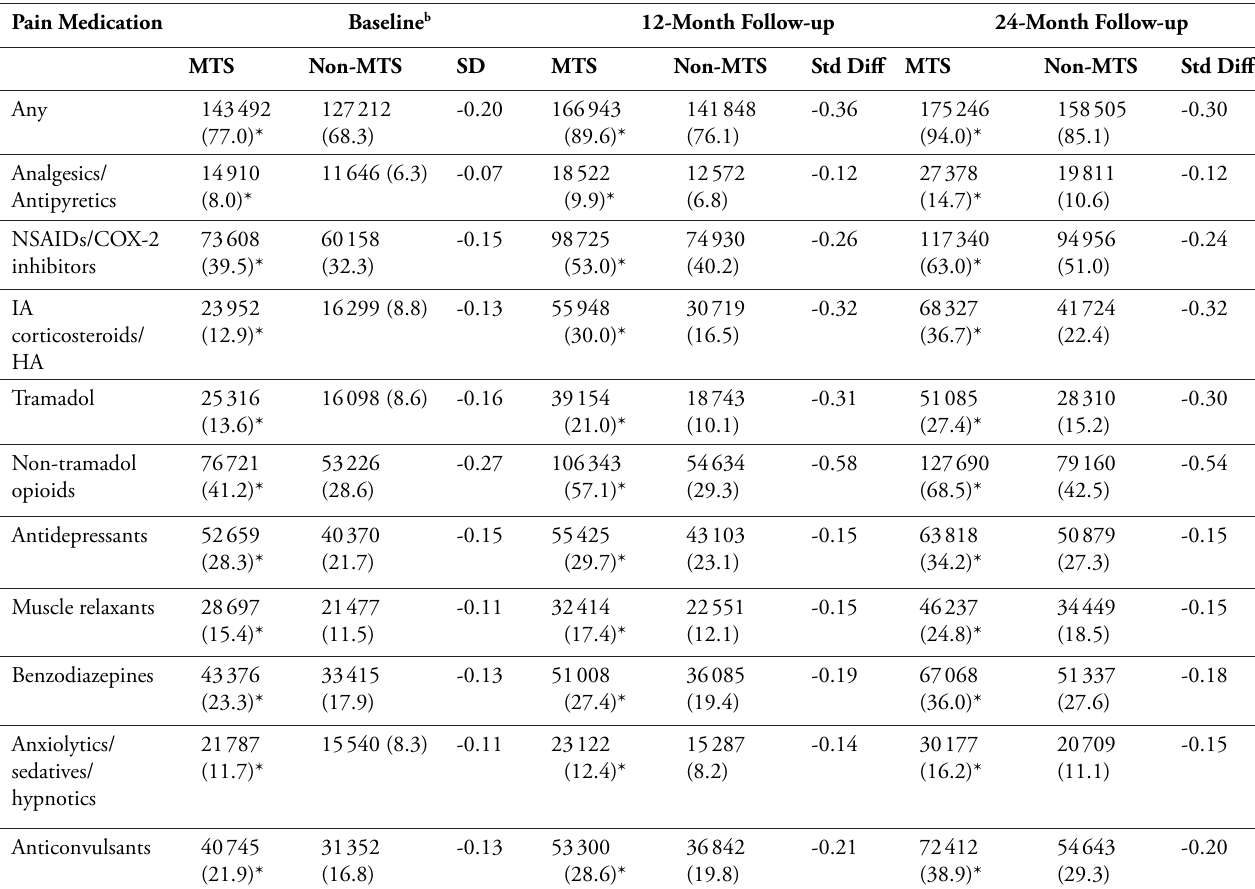
Table 2. Patients (%) with Pain Medication Prescriptions at Baseline and 12- and 24-Month Follow-up in the Propensity Score–Matched Cohorts